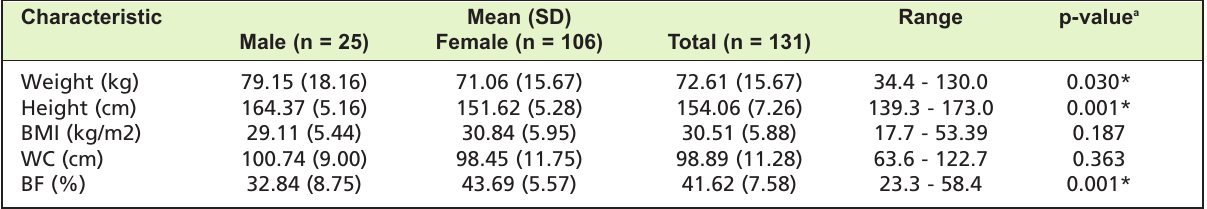
Anthropometric measurements according to gender (n = 131) Table I: